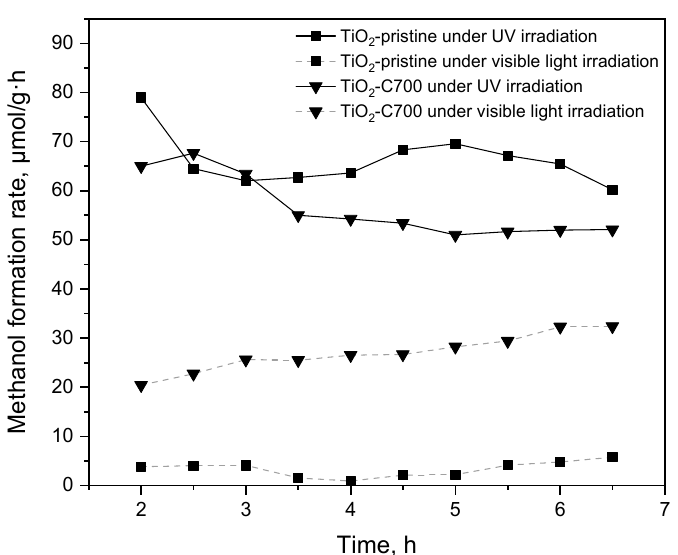
Figure 8. The photocatalytic activity of TiO 2 samples under UV and visible light irradiation as a function of reaction time on stream at 100 °C.